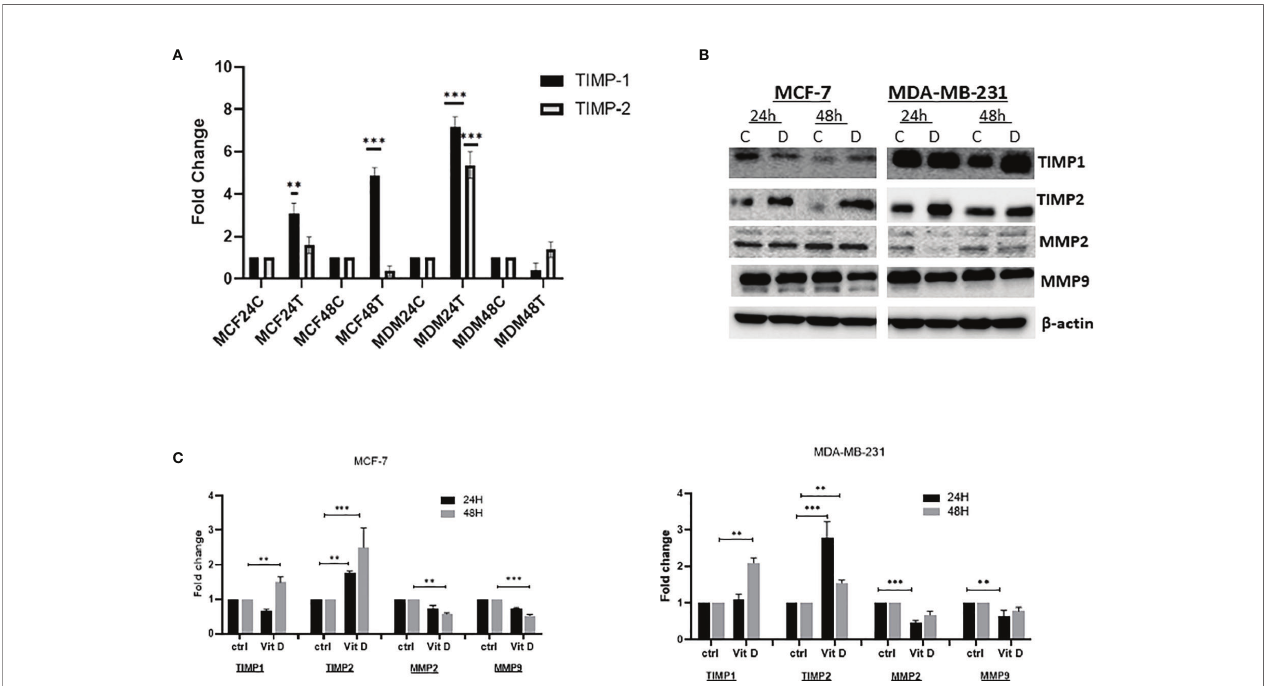
FIGURE 2 | Expression levels of TIMPs and MMPs in MCF-7 and MDA-MB-231 cell lines treated with calcitriol for 24 and 48 h. (A) qRT-PCR analysis of TIMP1 and TIMP2 gene expression levels. (B) Western bolt analysis showing TIMP1, TIMP2, MMP-2, and MMP-9 protein levels in MCF-7 and MDA-MB-231 cells treated with 10 µM of calcitriol and cultured for 24 and 48 h. (B) *** p < 0.01, determined using unpaired two-tailed Student ’ s t-test. Representative immunoblots depicting protein levels where b -actin was used as loading control. (C) Quantitative analysis of relative protein band density after normalization to b -actin and compared in MCF-7 and MDA-MB-231 cells treated with 10 µM of calcitriol and cultured for 24 and 48 h and compared to the control. (*) represents statistically signi fi cant change in viability between the indicated treatment groups at given time points. **p < 0.05; ***p < 0.001. TIMPs, tissue inhibitors of metalloproteinases; MMPs, matrix